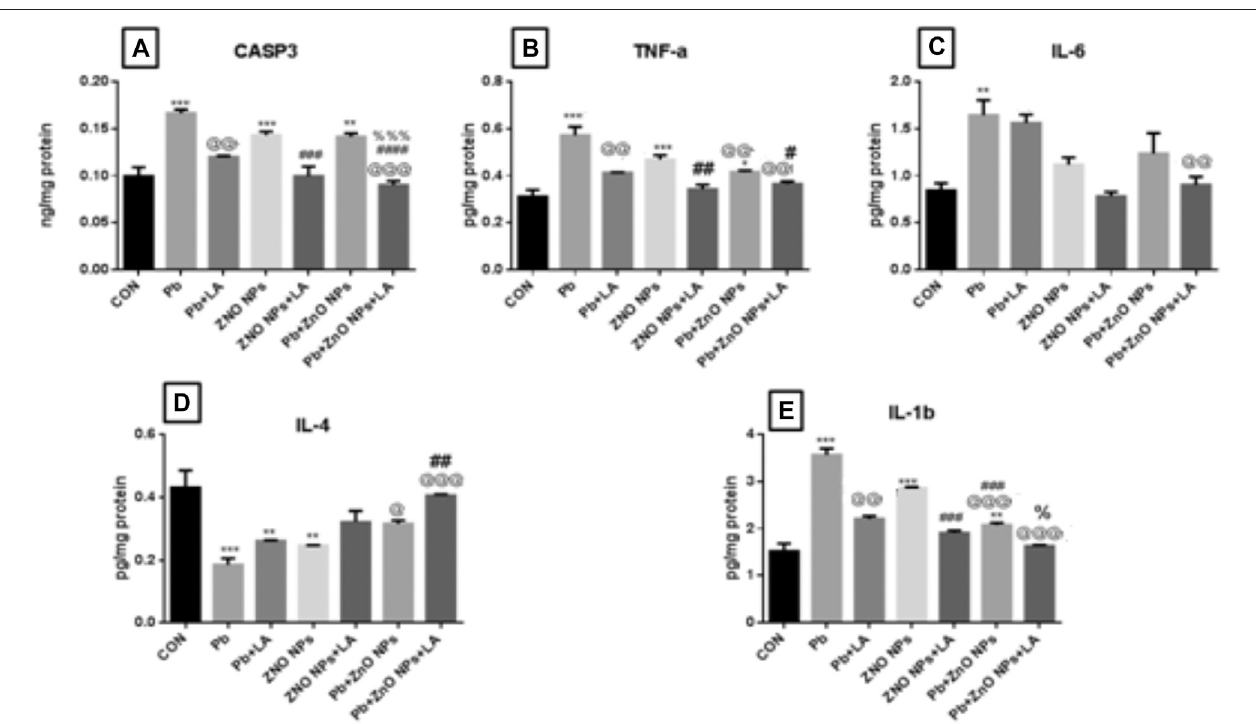
FIGURE13| Ratspleencaspase-3andcytokinelevels: (A) CASP3; (B) TNFa; (C) IL-6; (D) IL-4;and (E) IL-1b. Allthevaluesareexpressed asmean ± SEM(n (cid:2) 4). The statistical signi fi cance was considered at p < 0.05, and statistical analysis was performed using one-way ANOVA, followed by Tukey ’ s test. * p < 0.05, ** p <